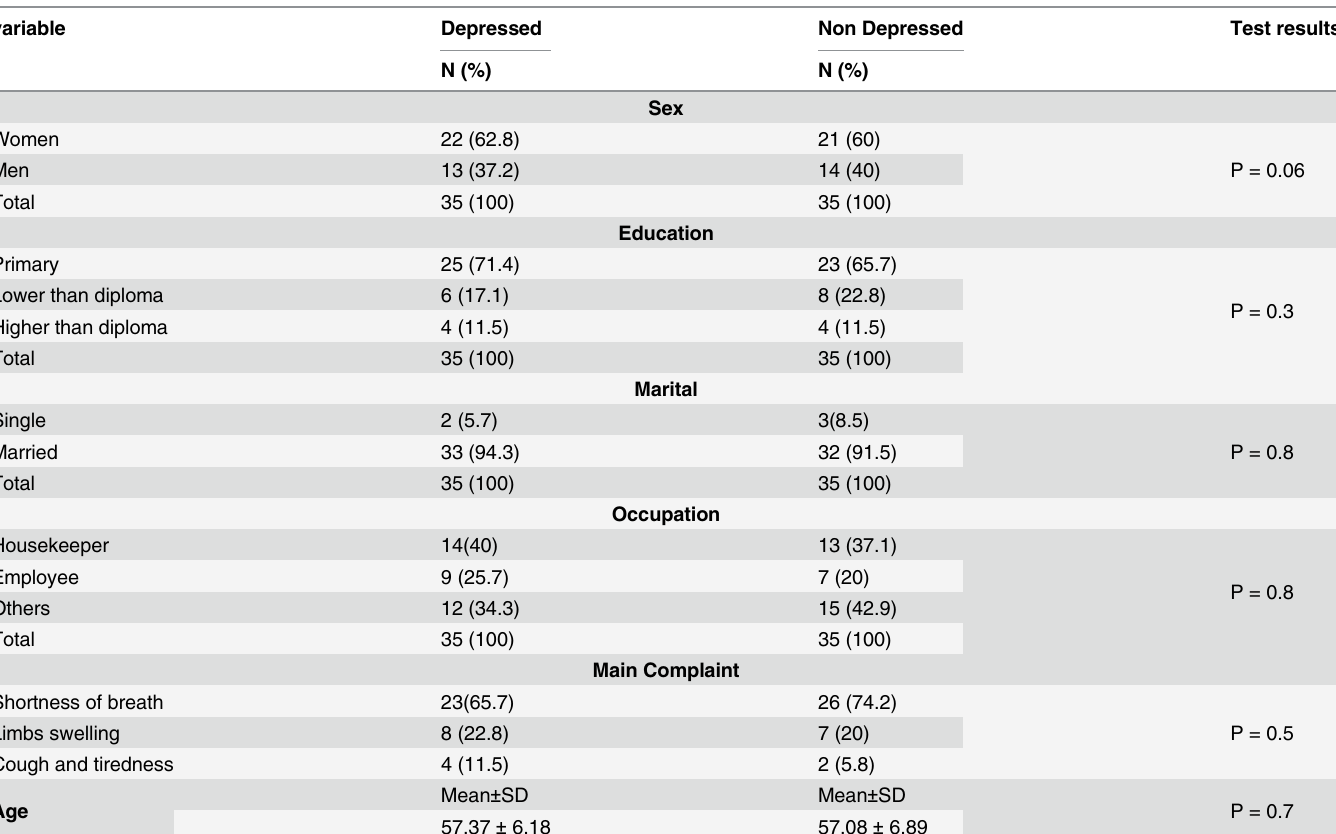
Table 2. Demographic Characteristics of Depressed and Non-depressed